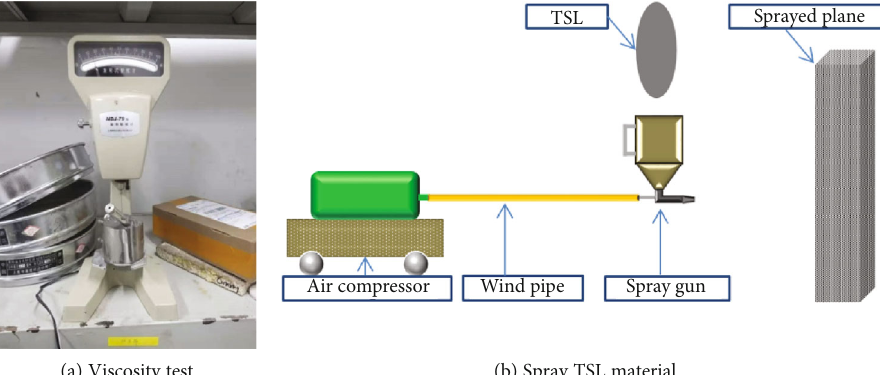
Figure 1: Viscosity test and spray TSL material.